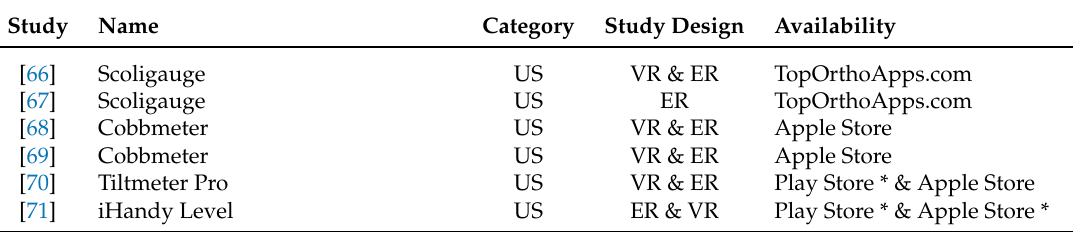
Table 7. Summary of reviewed